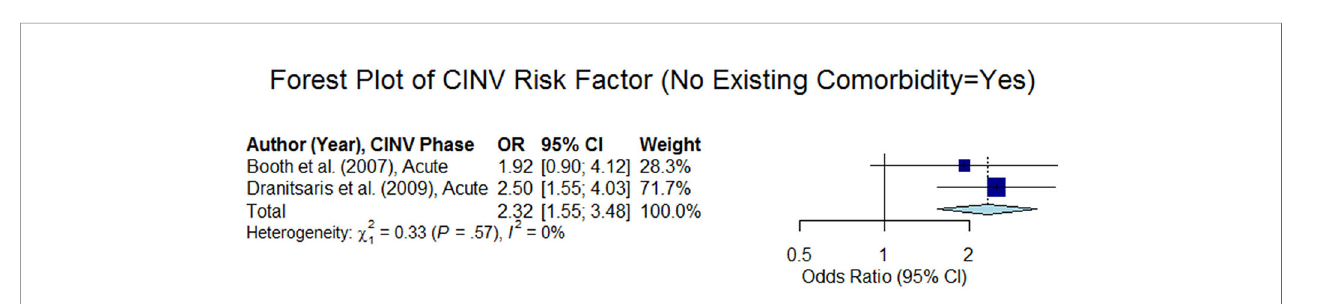
FIGURE 10 | Forest plot of Chemotherapy-Induced Nausea and Vomiting (CINV) risk factor (no existing comorbidity = yes).